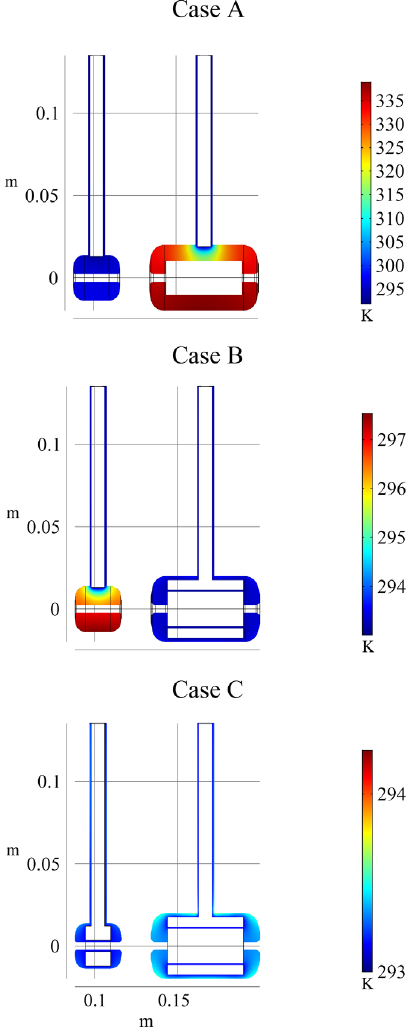
8. A comparison of different cooling strategies on the evacuation of the heat dissipation in long and small drift tubes. The heat profile is plotted at the duty cycle of 10%. Note the different scales. Only the outer copper shell is shown, open areas contain cooling circuits and the PMQ in